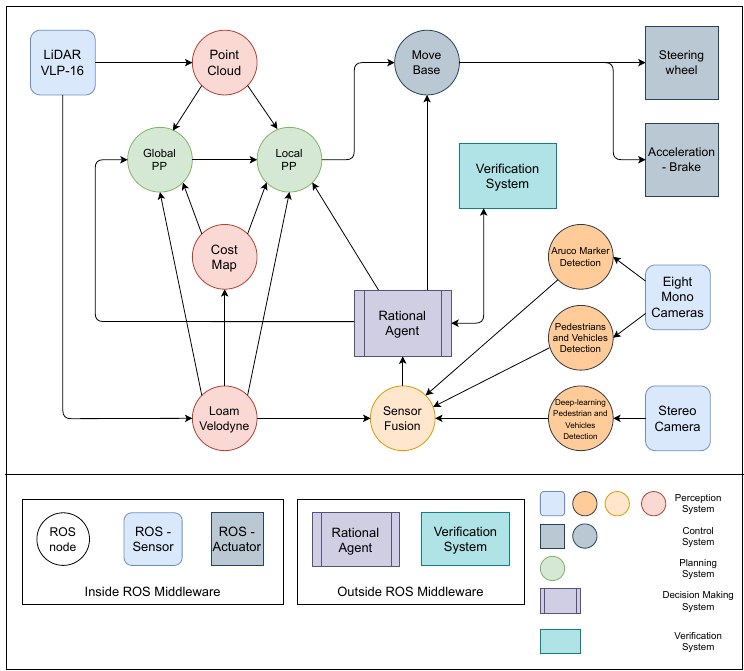
Figure 4. Our AV system showing the main nodes designed in ROS for perception, planning, and control (secondary and supporting nodes are not shown here); RA was designed in sEnglish [17,52], whereas the verification system was designed in MCMAS and PRISM verification